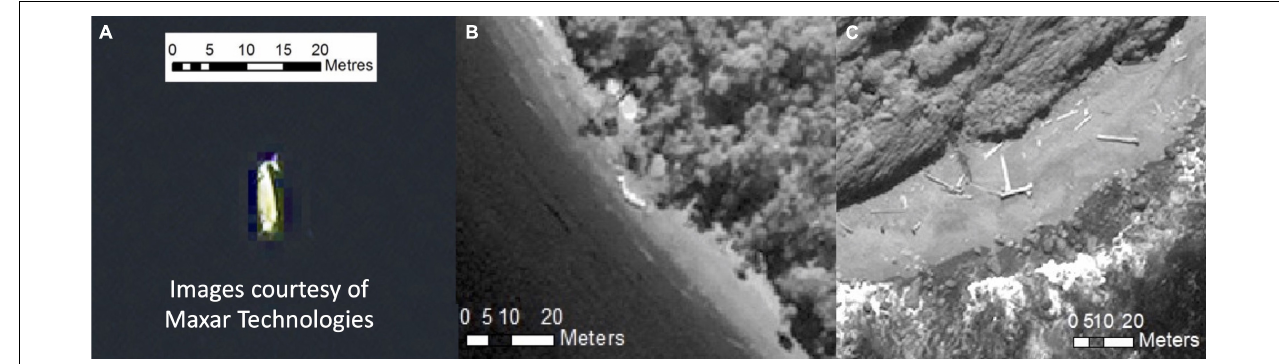
FIGURE 3 | (A) An image of a whale identified using VHR satellite imagery by Fretwell et al. (2019), showing visible whale-like features, e.g., a fluke. (B) An image of the only definite whale identified in the 2019 VHR satellite imagery from Golfo de Penas, displaying whale-like shape and size, but less defined whale-like features when compared with image (A) . (C) An image of wood along the coastline in the region of the case study, an example of a confounding feature when identifying cetaceans in the later stages of decomposition. All images are courtesy of Digital Globe Foundation (now Maxar